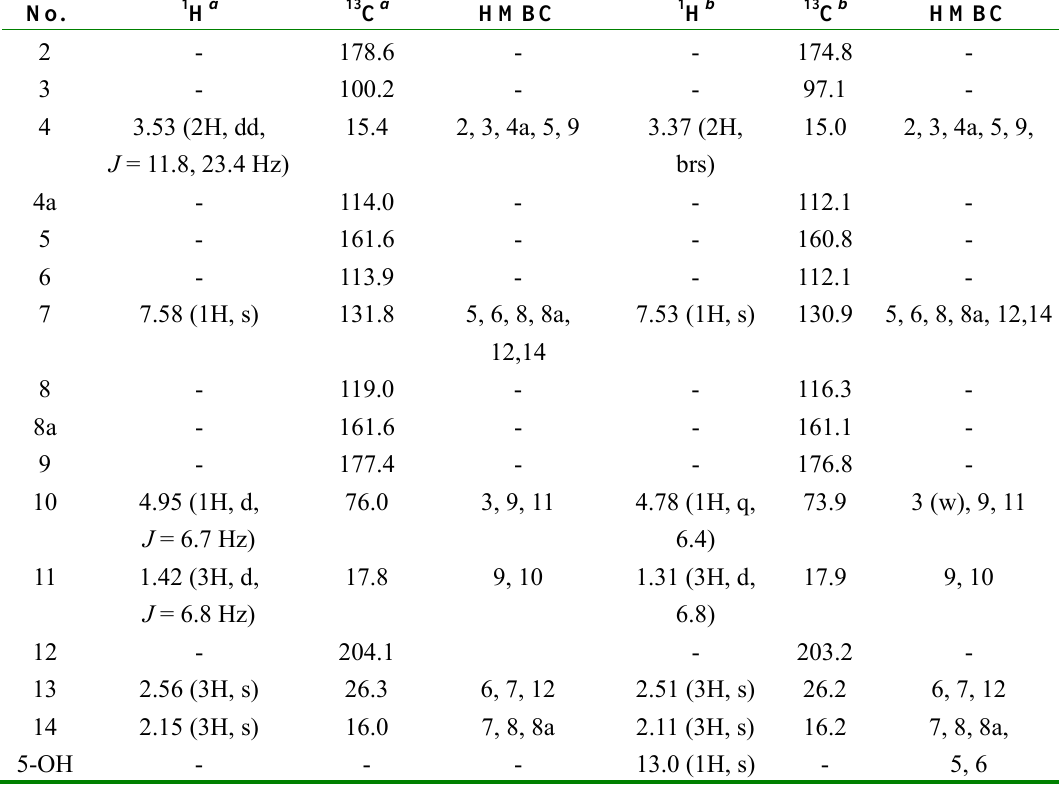
a and DMSO b , J in COCD 3 3